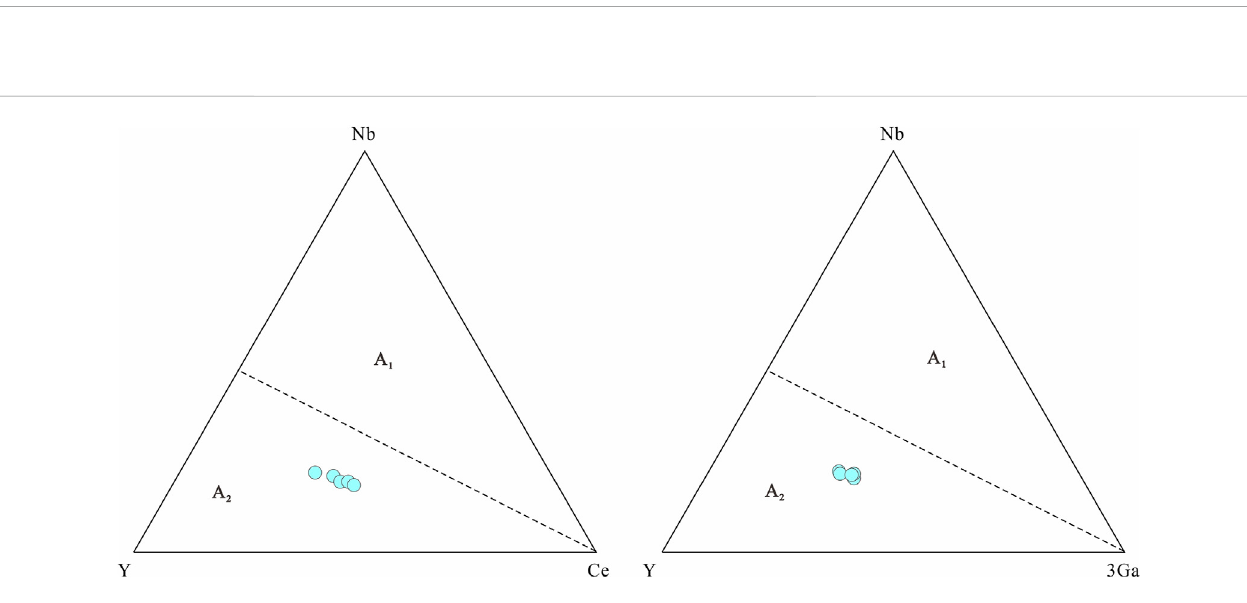
Frontiers in Earth